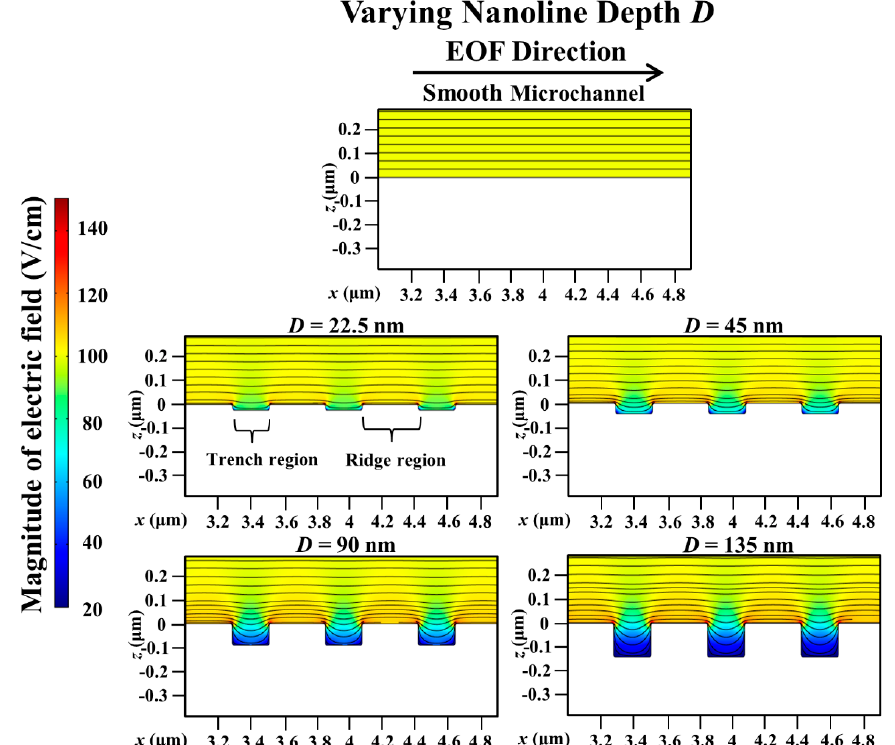
Figure 9. Simulated electric field distribution in microchannel with varying nanoline depth D , in comparison to smooth microchannel. Sodium bicarbonate (NaHCO 3 ) concentration was fixed at 1.0 mM, and nanoline orientation angle θ , width W , and period P were fixed at 45°, 160 nm, and 400 nm, respectively. When D increases, there is more distortion of electric field in the trench. As D gets deeper, distortion within the trench remains nearly constant.